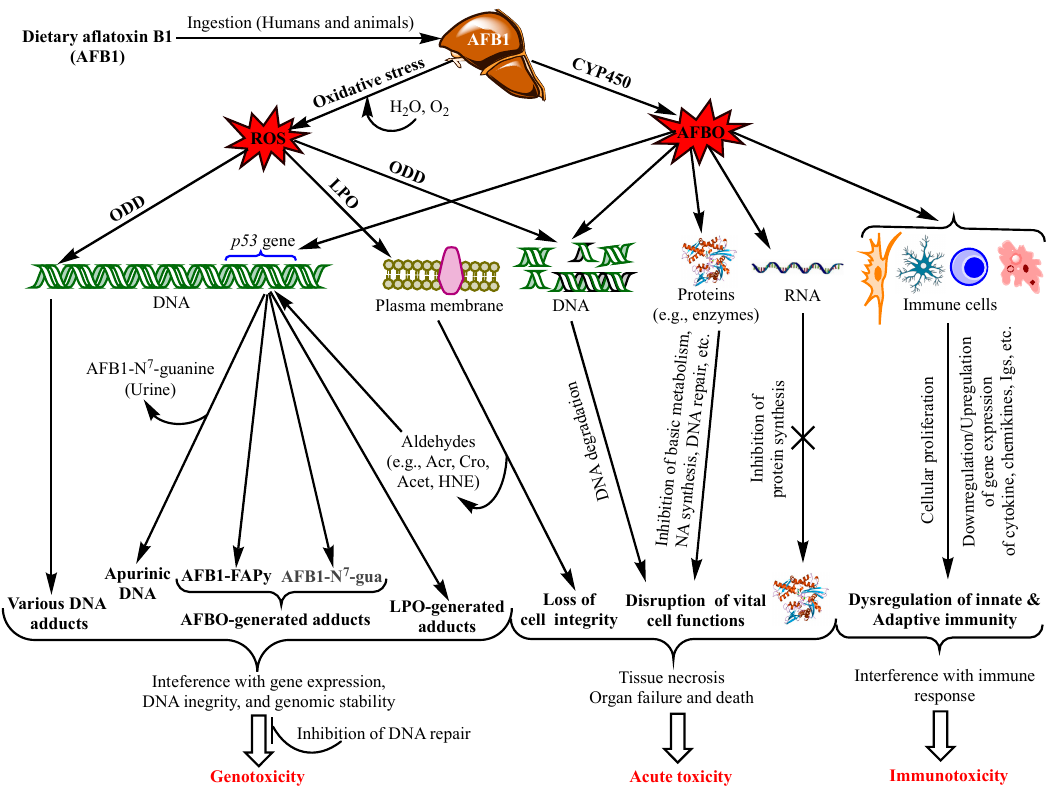
Figure 1. Main aflatoxin B1 toxicity mechanisms mediated by the oxidative stress and AFB1-exo-8,9 epoxide (AFBO; see text for explanations). NB: ROS also affect proteins, RNA molecules, and immunity as does AFBO (not shown in the figure. For details, see [20]). Abbreviations : AFBO: Aflatoxin